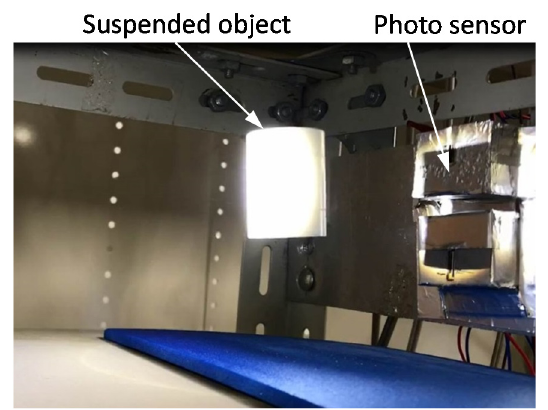
Figure 13. Photo of magnetically suspended object in the center.